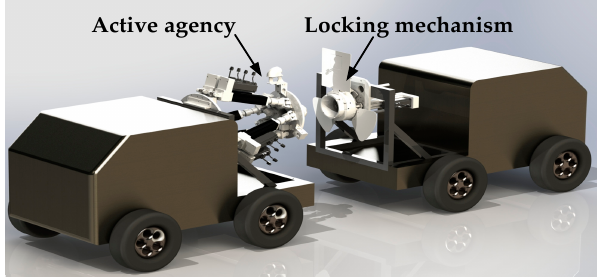
Figure 1. A rendering of the reconfiguration docking of an unmanned